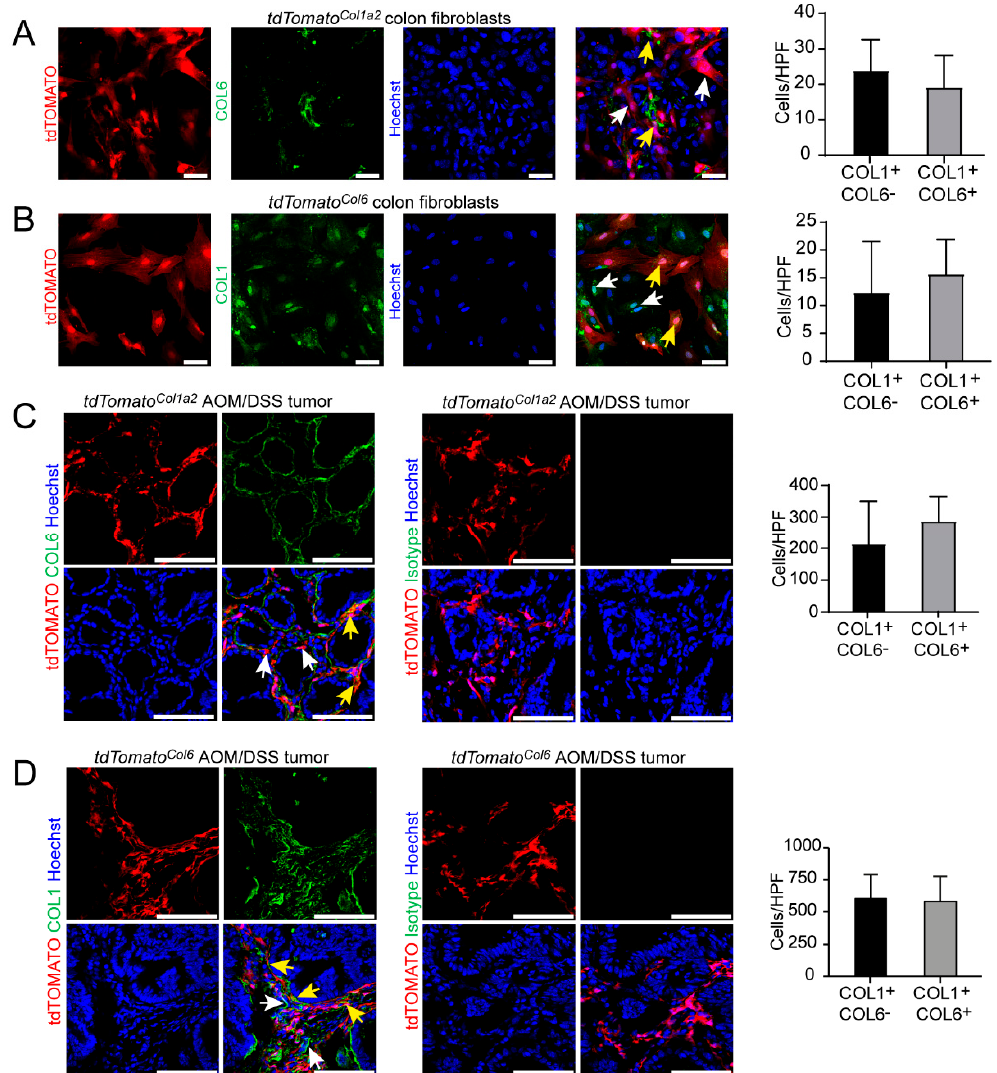
Figure 6. COL1+ fibroblasts represent a main fibroblast population and include a COL6+ subset in the unchallenged colon and the AOM/DSS model. ( A ) Colon fibroblasts were isolated from Tamoxifen administered tdTomato Col1a2 reporter mice with enzyme-based purification, stained with anti-Collagen 6 (green) and Hoechst (blue) and studied by confocal microscopy. For each sample, 4–5 representative HPFs were scored for the number of COL1+COL6+ (yellow arrows) and COL1+COL6- (white arrows) cells ( n = 4/group). Scale bar: 50 µm. ( B ) Colon fibroblasts were purified from tdTomato Col6 reporter mice, plated on chamber slides, stained with anti-Collagen 1 antibody (green) and Hoechst (blue) and examined by confocal microscopy. For each sample, 4–5 representative HPFs were scored for the number of COL1+COL6+ (yellow arrows) and COL1+COL6- (white arrows) cells ( n = 4/group). Scale bar: 50 µm. ( C ) Tissue sections of AOM/DSS tumors from tdTomato Col1a2 reporter mice were stained with immunofluorescently labeled anti-Collagen 6 or isotype control antibodies (green) and Hoechst (blue). For each sample, 4–5 representative HPFs were quantified for the number of COL1+COL6+ (yellow arrows) and COL1+COL6- (white arrows) cells ( n = 3/group). Scale bar: 100 µm. ( D ) Tumor tissue of AOM/DSS tumors from tdTomato Col6 reporter mice were stained with anti-Collagen 1 or isotype control antibodies (green) and Hoechst (blue) and analyzed by confocal fluorescent microscopy. For each sample, 4–5 representative HPFs were studied for the number of COL1+COL6+ (yellow arrows) and COL1+COL6- (white arrows) cells ( n = 3/group). Scale bar: 100 µm. The results are representative of at least two independent experiments.